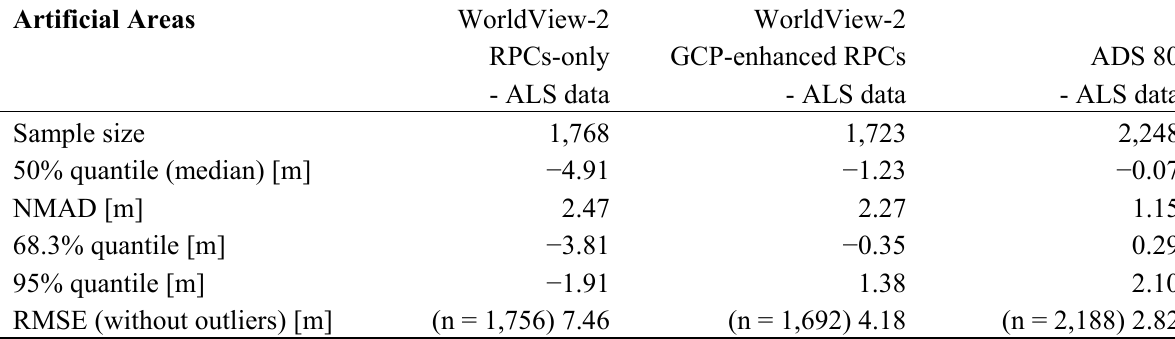
Table 9. Artificial areas. Vertical accuracy measures of the three digital surface models in comparison with the airborne laser